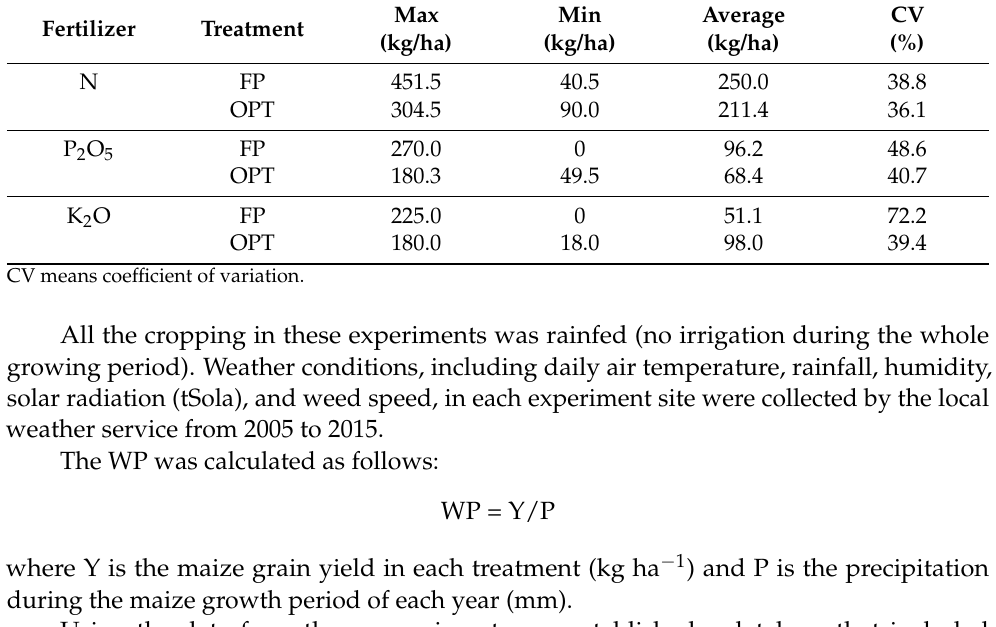
Table 1. Fertilizer application rates of farmers’ practices (FP) and optimized fertilizer management (OPT) treatments.